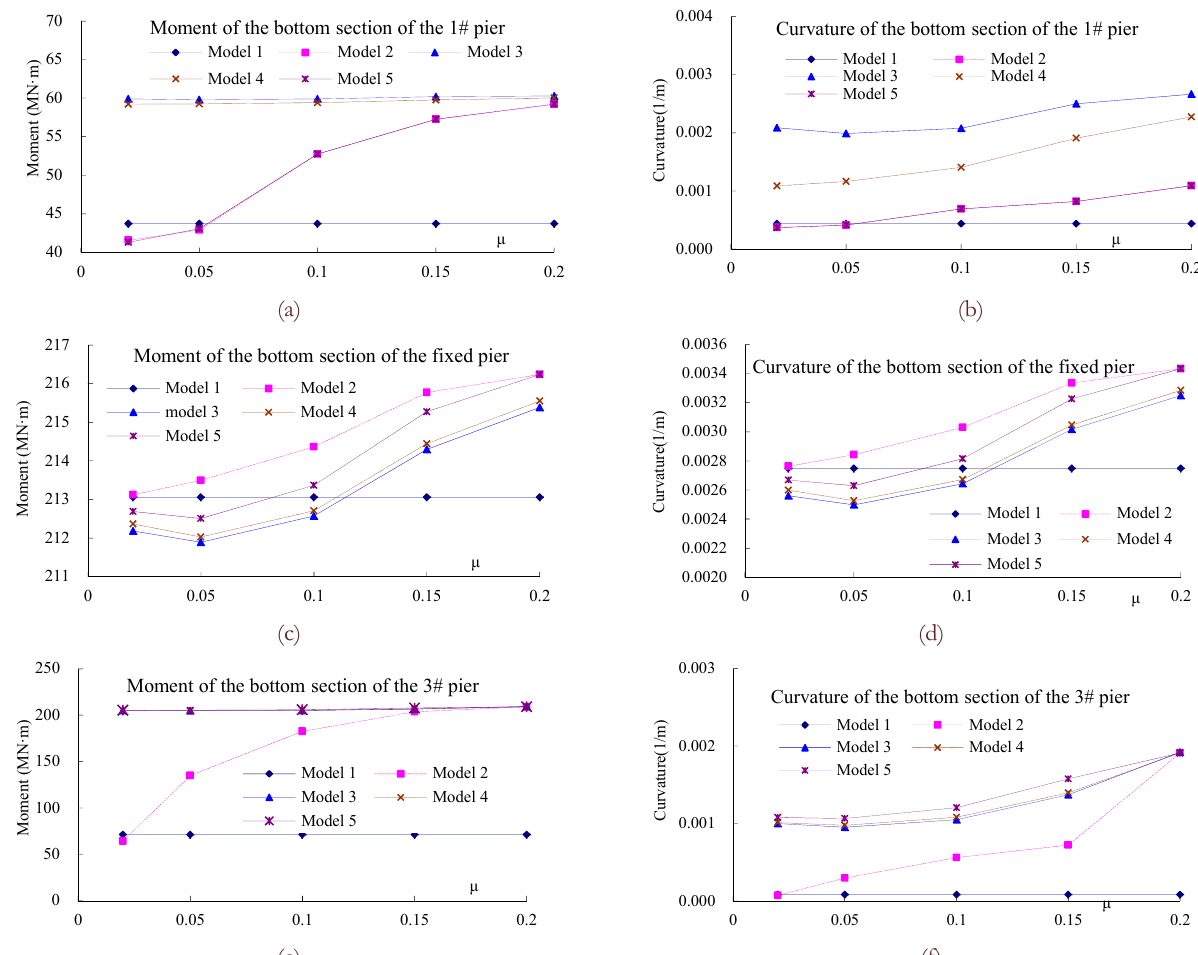
Figure 8: Moment and curvature of the bottom section under Tianjin seismic